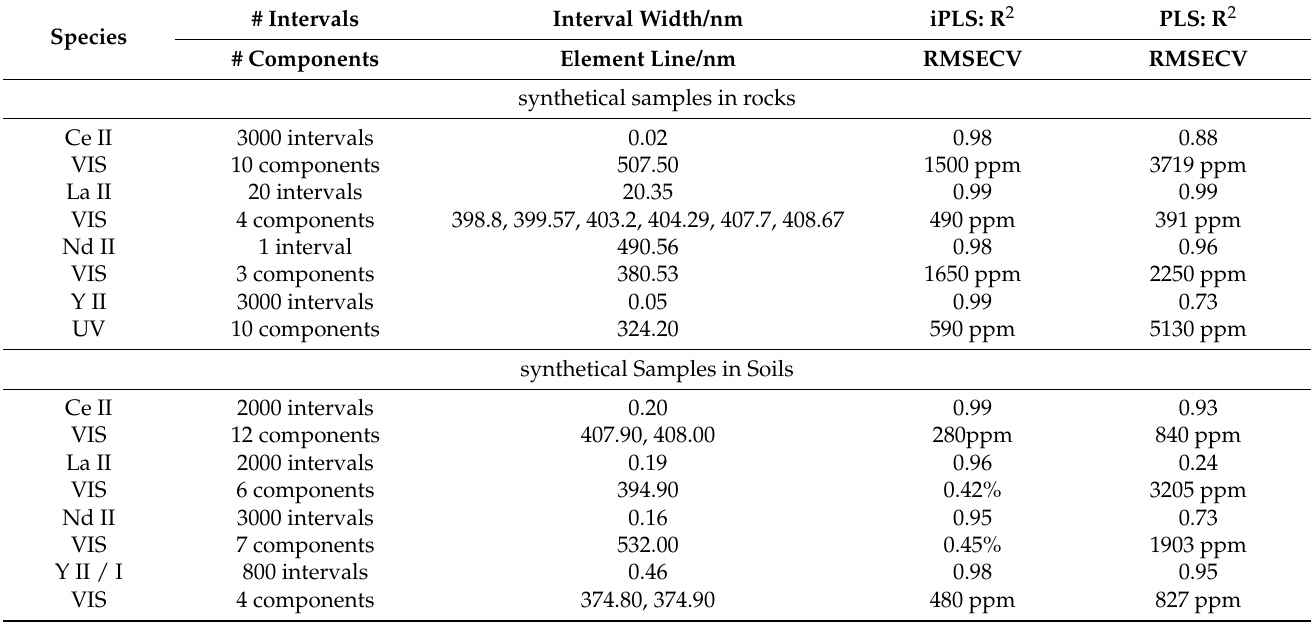
Table 4. Results of i PLS regression of synthetic samples in rocks and